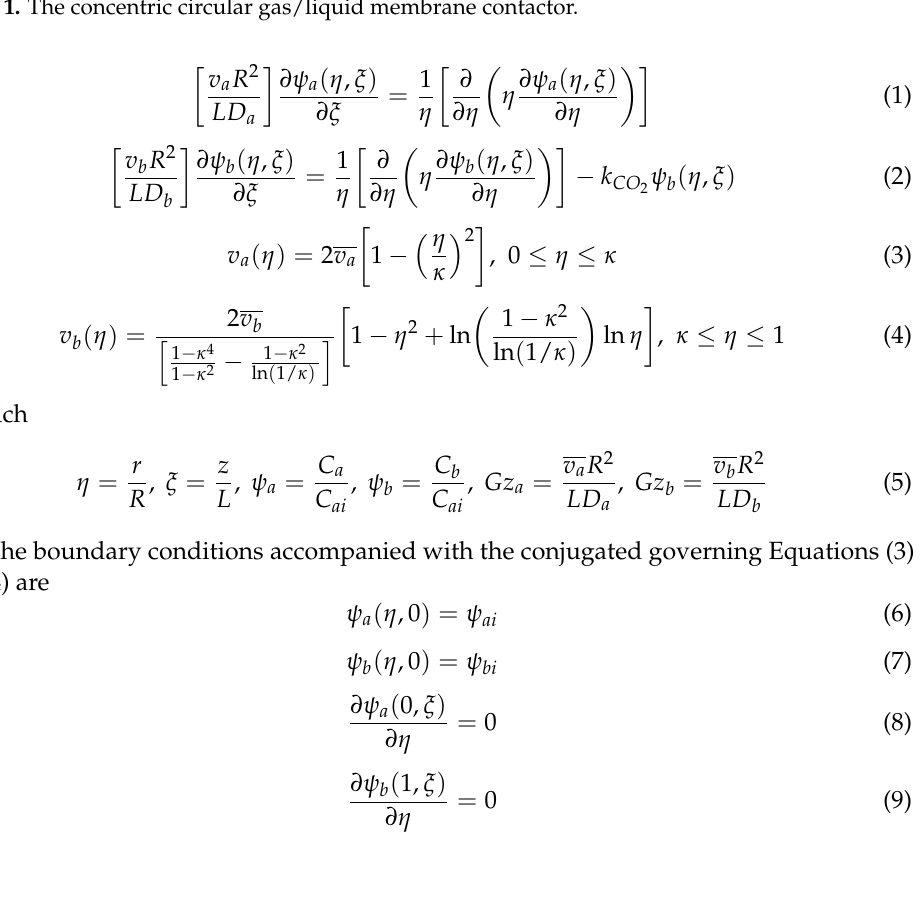
Figure 1. The concentric circular gas/liquid membrane contactor.